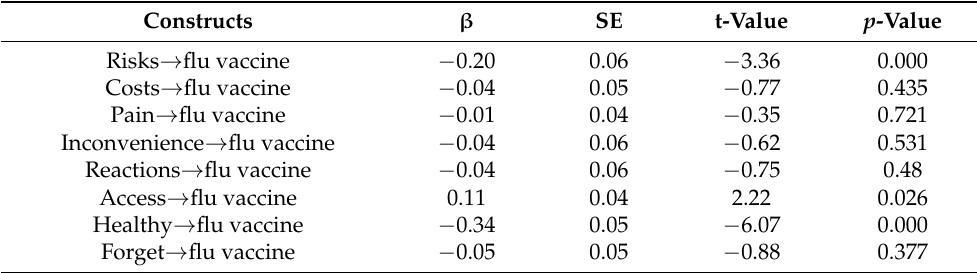
Table 9. Effects inference—flu vaccine willingness.